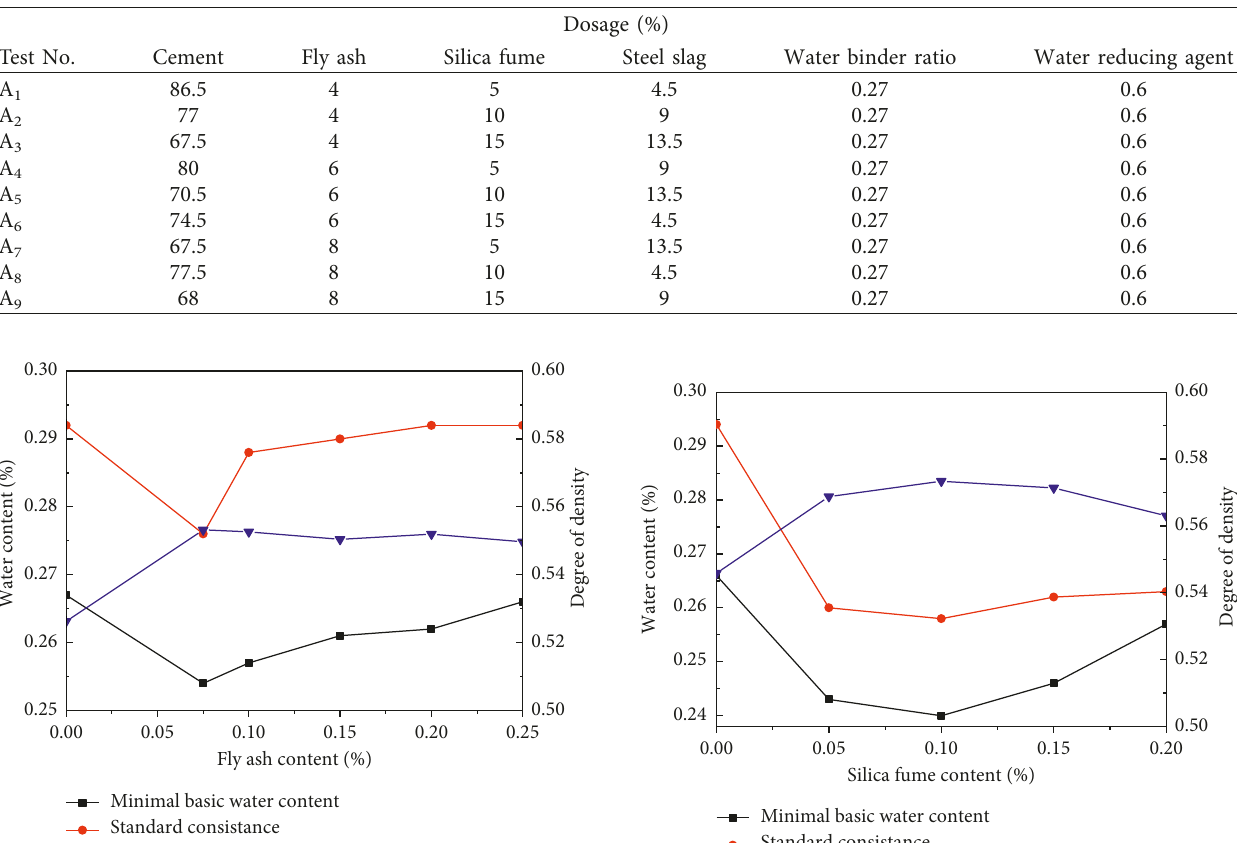
Table 3: Mix ratios of compound cement paste.